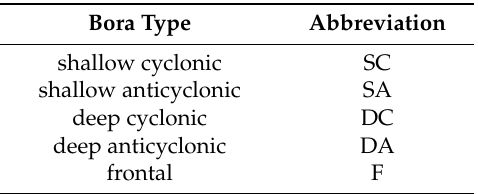
Table 1. The main bora type categories.